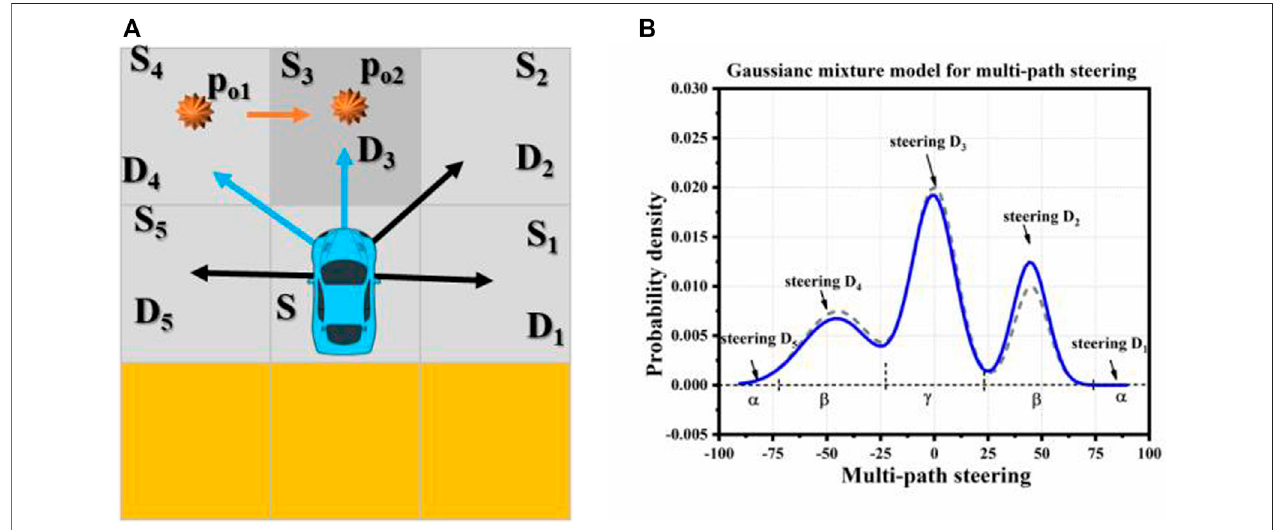
FIGURE 24 | There is no obvious difference in the distribution of new and old steering. (A) Expected driving direction of vehicles and position of obstacle intrusion. (B) New and old steering distribution.